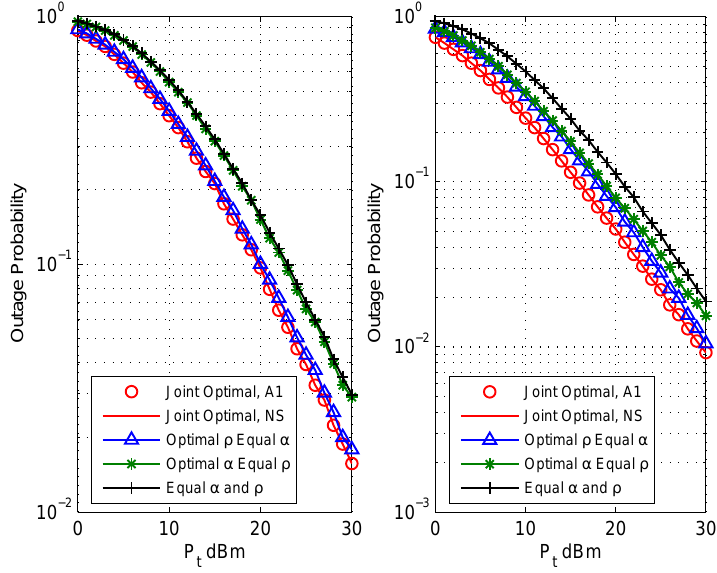
Figure 2. Comparison of outage performance vs. the total power constraint of different resource allocation schemes: ( a ) ( d 1 , d 2 ) = ( 5,5 ) (the left figure); ( b ) ( d 1 , d 2 ) = ( 3,7 ) (the right